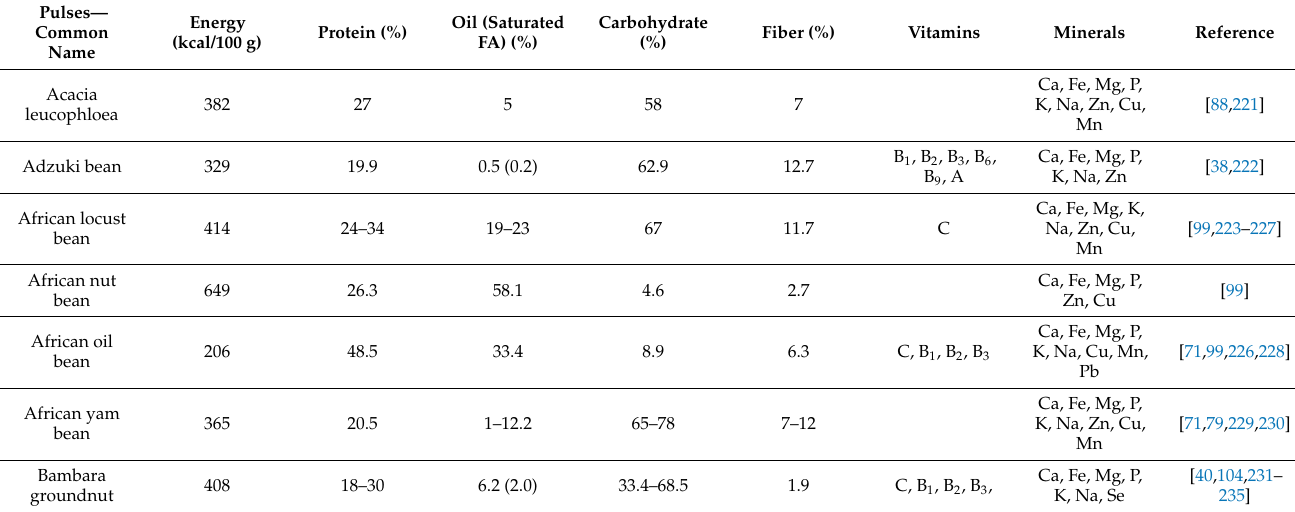
Table A2. Nutritional composition of minor pulses, in grey major